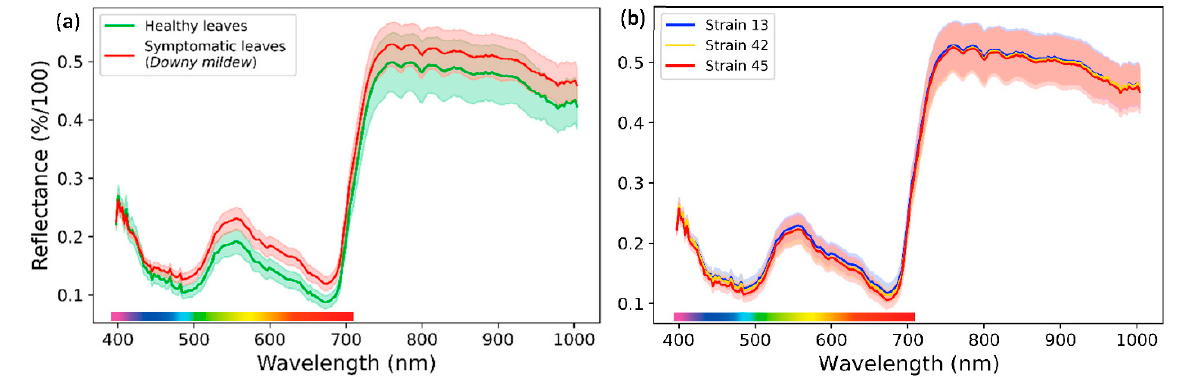
Figure 3. Normalized average light reflectance spectrum with standard deviation between 400 and 1000 nm of grapevine cultivar ‘Cabernet-Sauvignon’ leaf areas inoculated 9 days before with P. viticola . ( a ) Spectrum of healthy leaves’ areas (green) or symptomatic leaves’ areas covered by whitish downy mildew (red). Whitish downy mildew reflected more the light than a healthy leaf, especially in the visible part of the light spectrum between 400 and 700 nm; ( b ) Spectrum of symptomatic leaves’ areas covered by downy mildew strains INRA-Pv13 (blue), INRA-Pv42 (yellow) and INRA-Pv45 (red). The three strains had the same spectral signature.